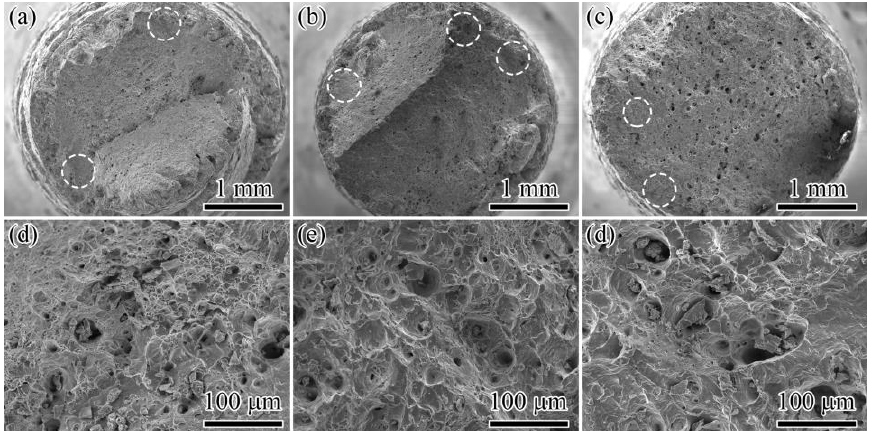
Figure 11. The stress rupture fracture surfaces of 15Cr–15Ni–Ti–xP alloy after stress rupture testing at 650 °C/195 MPa: ( a , d ) 15Cr–15Ni–Ti–70P, ( b , e ) 15Cr–15Ni–Ti–150P and ( c , f ) 15Cr–15Ni–Ti–250P.